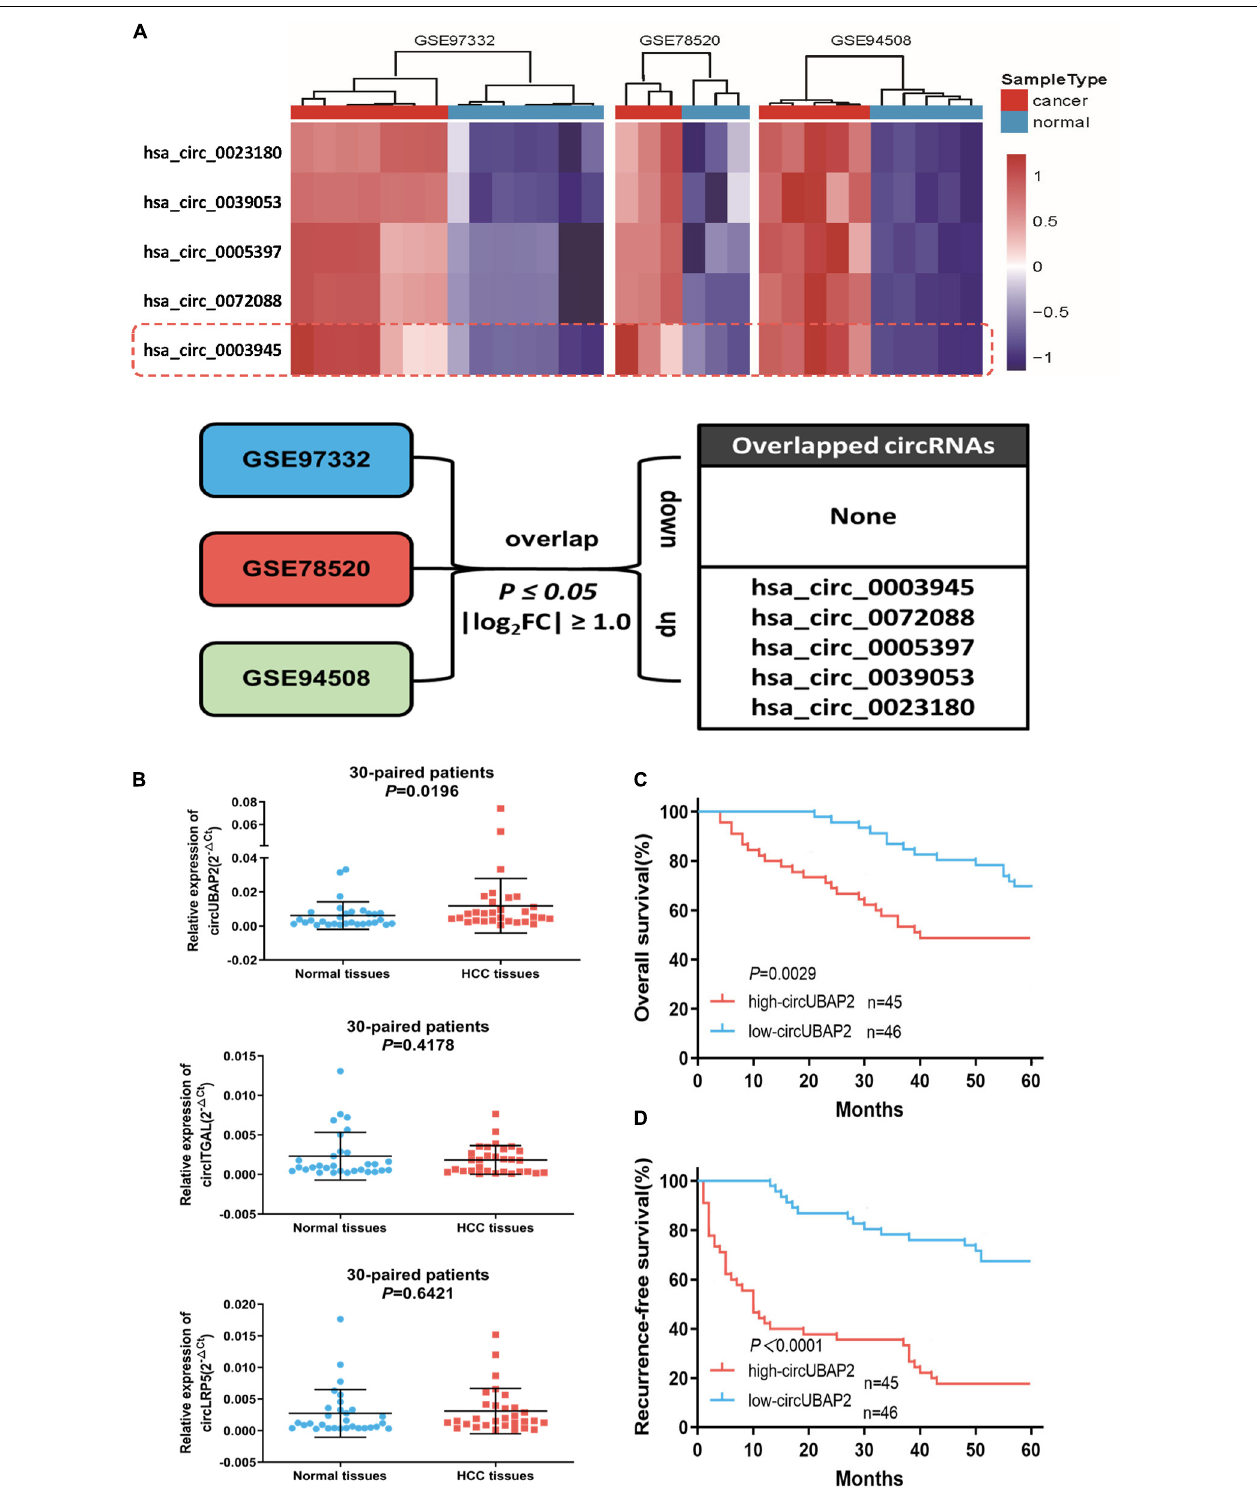
FIGURE 1 | CircUBAP2 was significantly overexpressed in HCC and predicted poor prognosis (A) . The overlap of altered circRNAs in GSE97332, GSE78520, and GSE94508 datasets. (B) RT-qPCR was used to further validate the differences in the expression of three candidate circRNAs in 30 HCC tissues and paired normal tissues. (C,D) Kaplan–Meier curves showing overall survival (C) and disease-free survival (D) of 91 HCC patients followed up to 60 months. Patients were separated by the median expression level of circUBAP2.